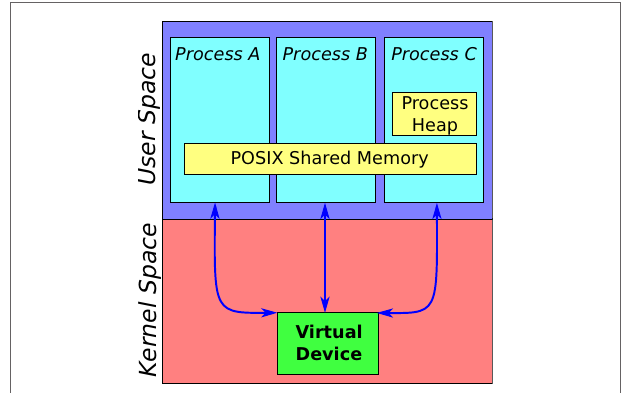
FigUre 2 | Backing memory locations for ach channels . Channels in the process heap are private to the process. Channels in POSIX shared memory are accessible by multiple processes. The kernel channels presented in this paper are available through per-channel virtual devices and are also accessible by multiple processes. The virtual devices are accessed from user space through file descriptors, meaning the kernel channels can be multiplexed via select , poll , etc. Because kernel channels are in protected kernel memory, they cannot be corrupted by rogue